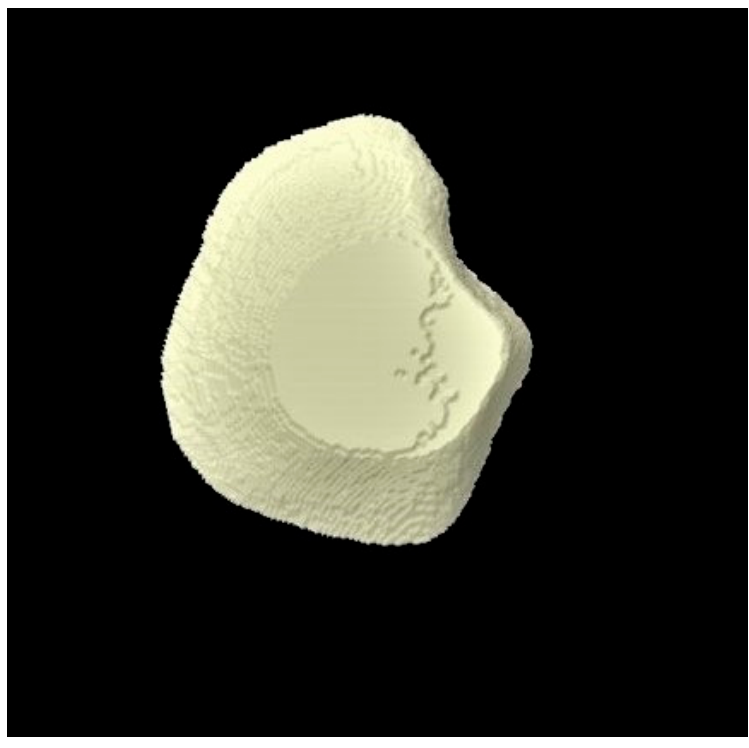
Figure 8. Micro-CT image of group 3 samples presenting enamel surface at baseline.